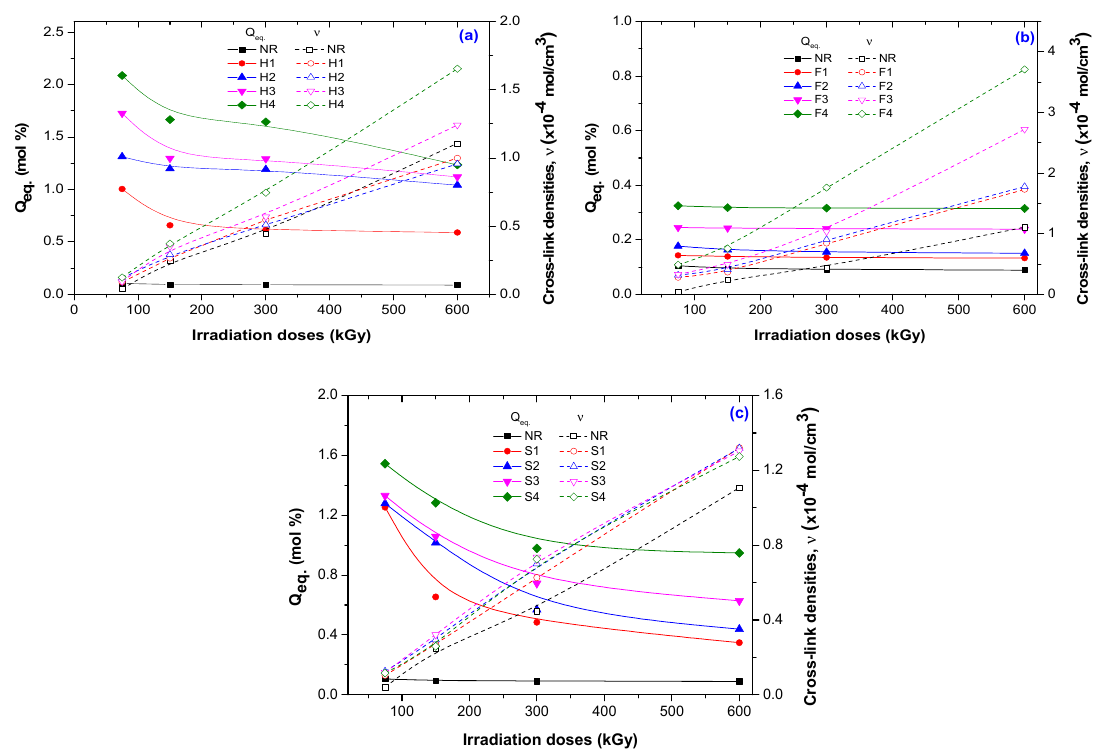
Figure 8. Q eq. (mol%) vs. cross-link densities ( ν ) [42,44,45] of NR samples reinforced with hemp ( a ), flax ( b ) , and sawdust ( c ).